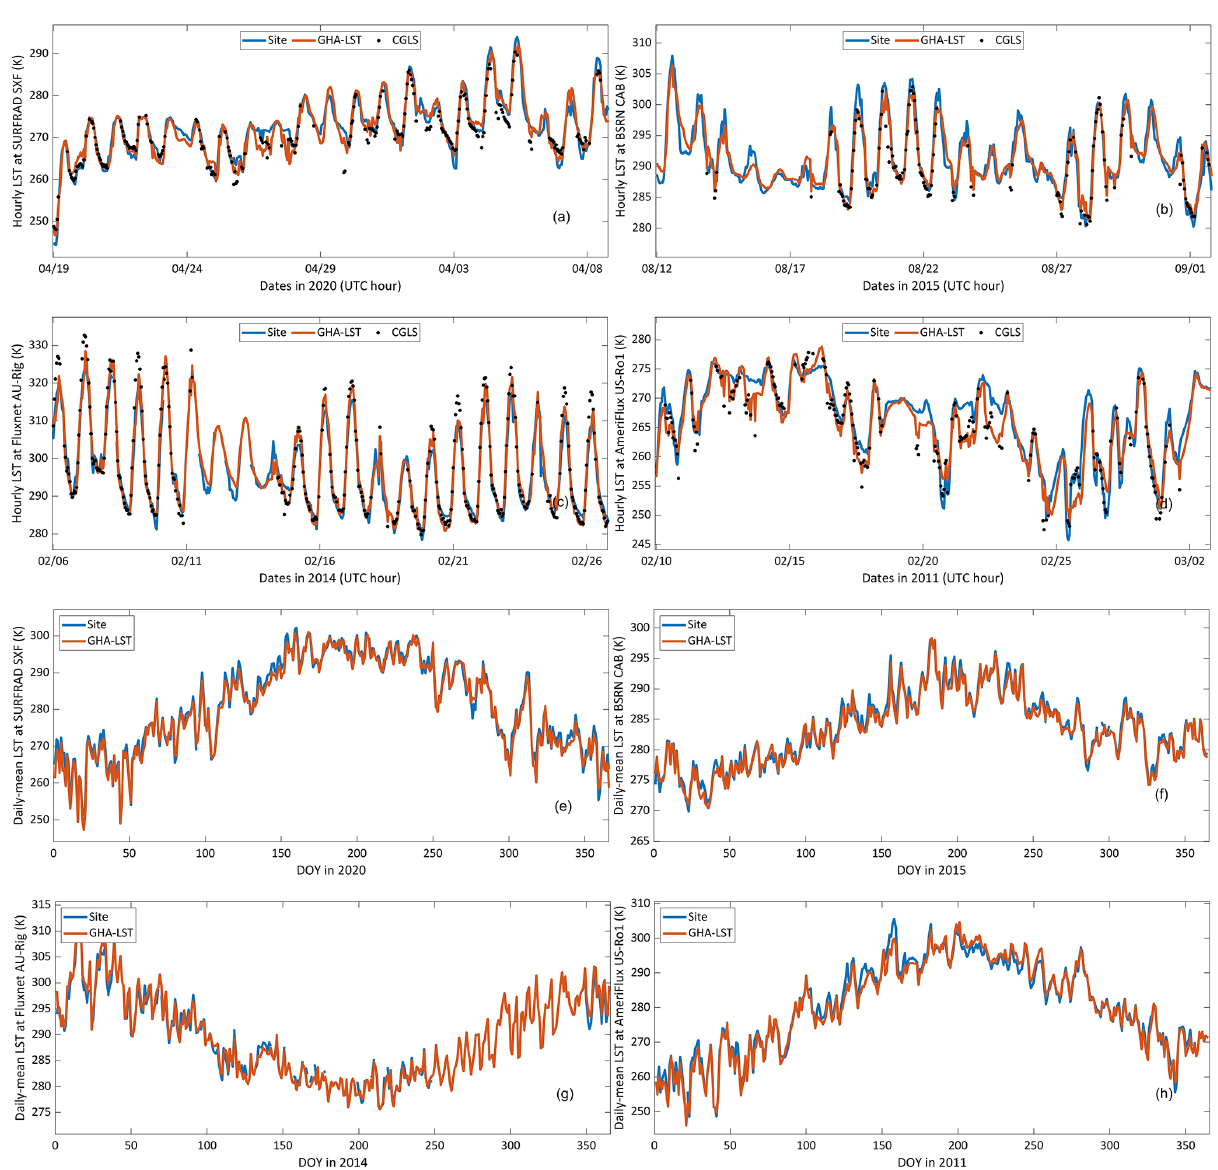
Figure 7. Temporal variation in the (a–d) hourly LST and (e–h) daily mean LST at four sites: (a, e) SURFRAD SXF, (b, f) BSRN CAB, (c, g) Fluxnet AU-Rig, and (d, h) AmeriFlux US-Ro1. The abbreviations used in the figure are as follows: SURFRAD SXF – “Surface